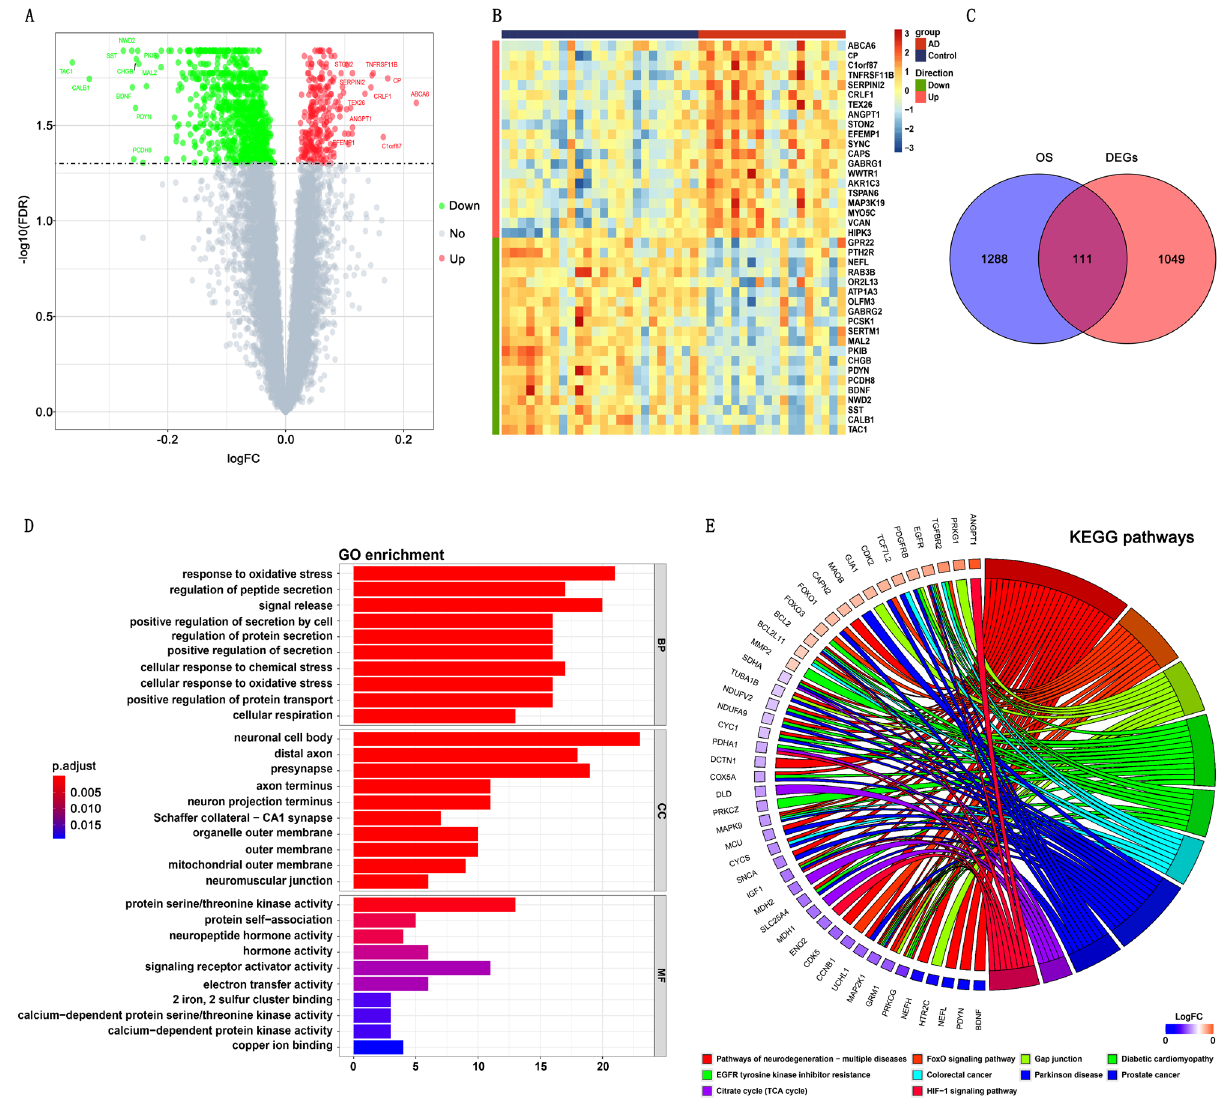
Figure 2. ( A ) Volcano plots of differentially expressed genes (DEGs). The red dots represent upregulated genes, and the green dots represent downregulated genes. ( B ) Heatmaps of DEGs. ( C ) An overlap of 111 DEOSGs between DEGs and OS-related genes in Venn diagram. ( D ) GO analysis of DEOSGs. ( E ) KEGG pathway enrichment analysis of